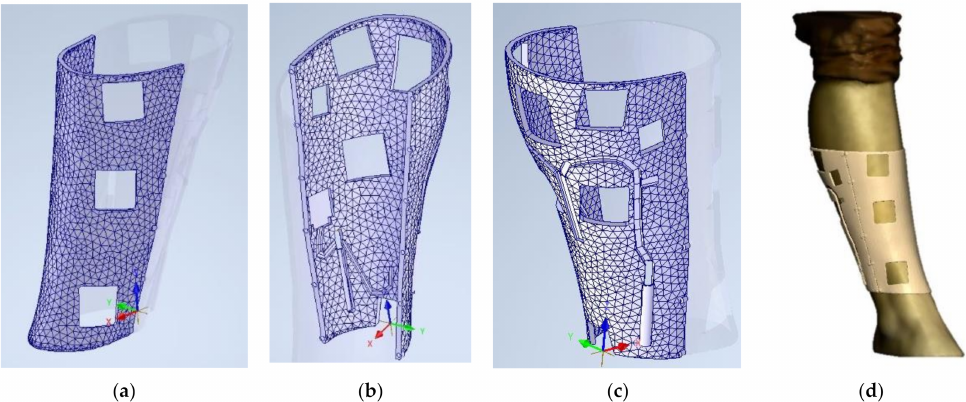
Figure 10. View of the splint: front part ( a ), inside ( b ) outside ( c ) from the back part of the splint. ( d ) designed splint over the scanned